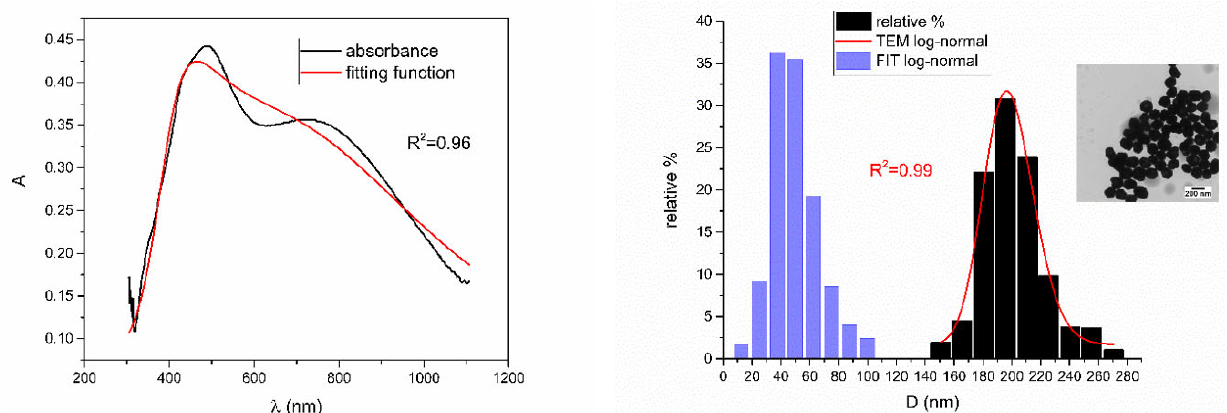
Figure 10. UV ‐ Vis spectrum with fitting function ( left ) for sample NanoX_1. Reported and recon ‐ structed size distributions are shown on the right . An additional TEM image is also shown.